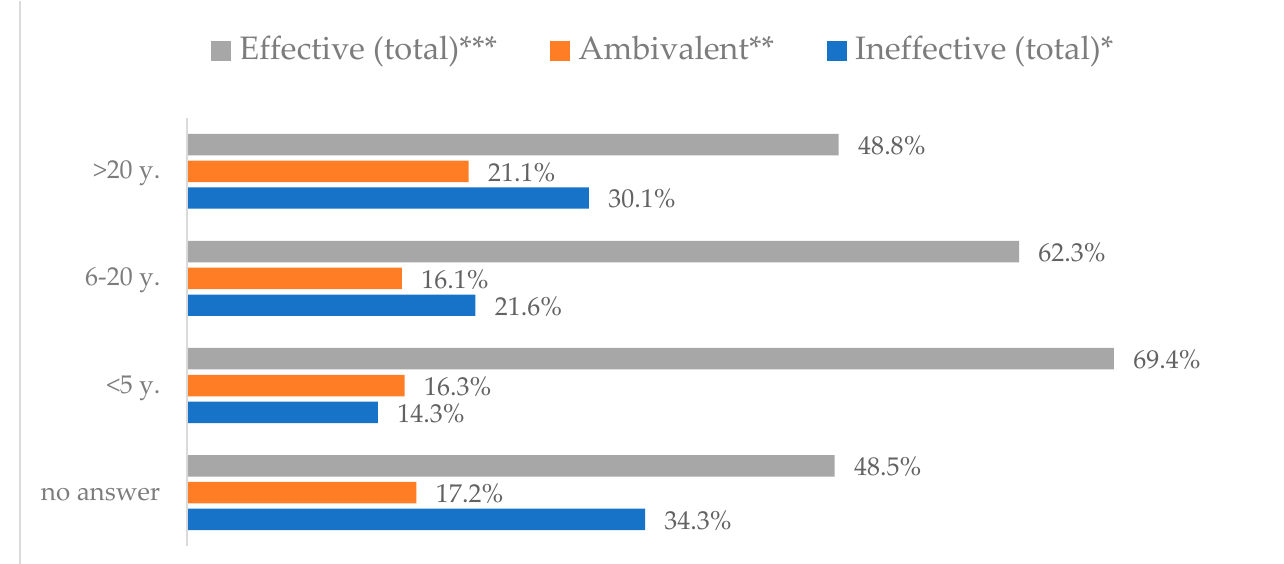
Figure 15. Influenza vaccination to prevent influenza virus infection by seniority ( N = 905). *Sum of